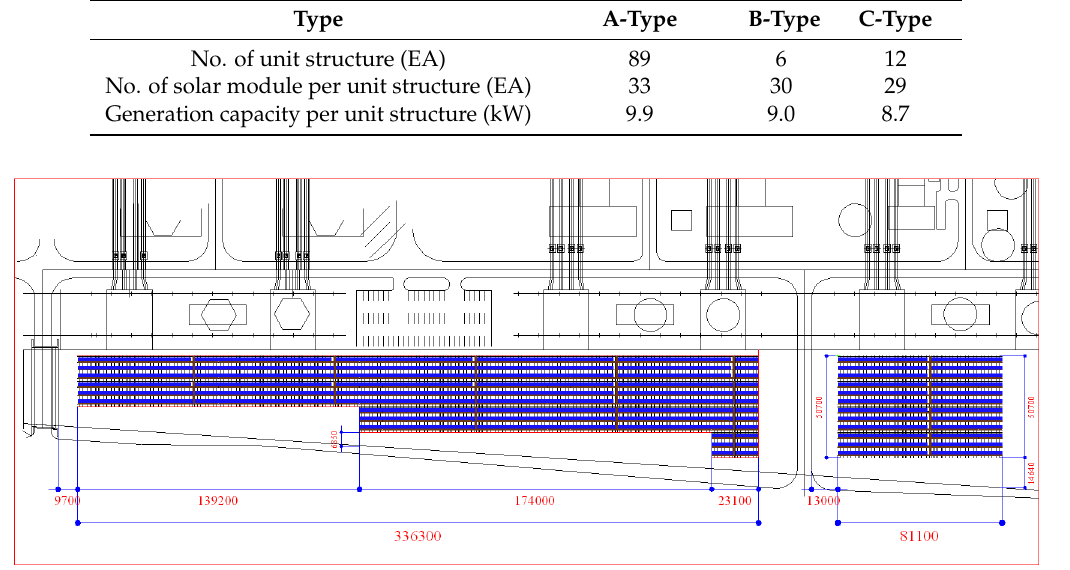
Figure 4. Composition of floating PV generation complex (Unit: mm).